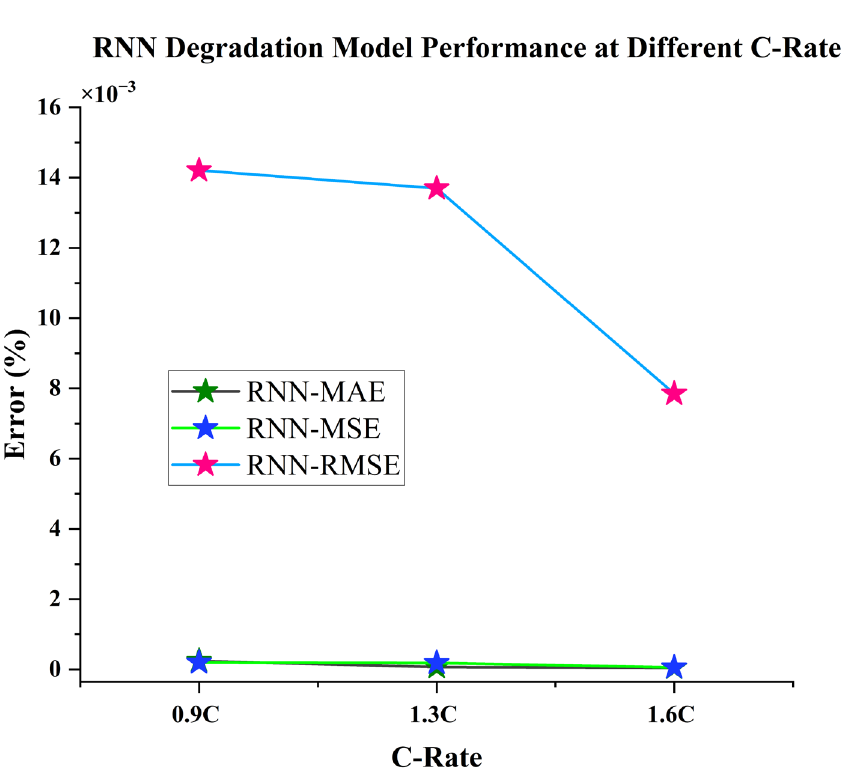
Figure 11. The performance of the RNN degradation model based on the MAE (%), MSE (%), and RMSE (%) values at 3 separate accelerated discharge rates: 0.9C, 1.3C, and 1.6C.